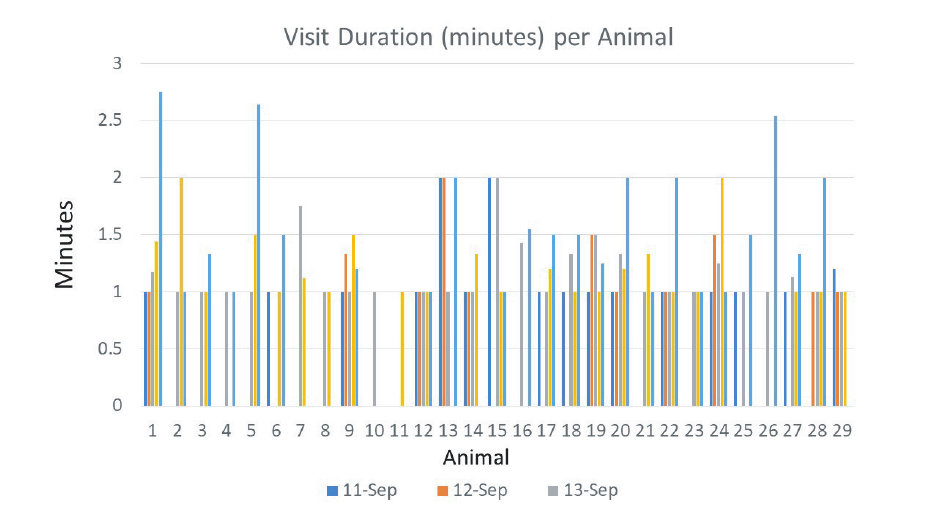
Figure 17. Recorded visit duration by individual